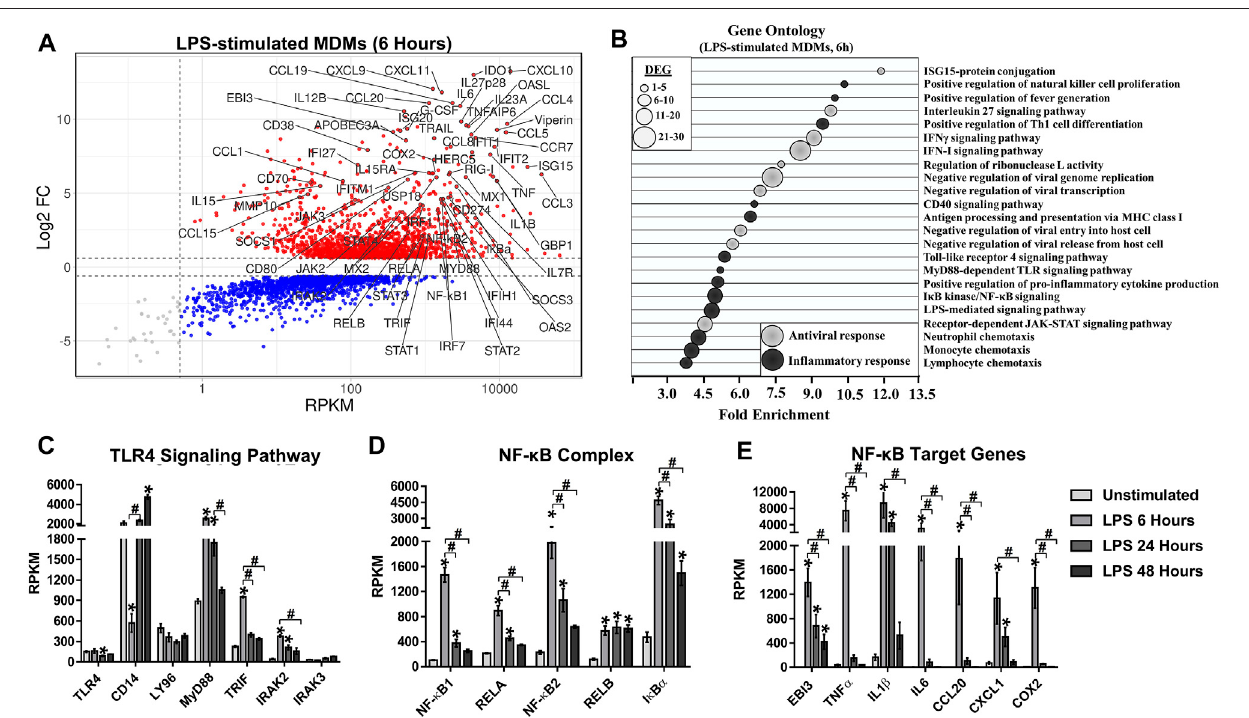
FIGURE 3 | TLR4 activation in human MDMs triggers NF- κ B-complex activation which drives the NF- κ B-target genes expression. We reanalyzed a publicly availableRNA-seqdataset[(GSE84188(GEO)(Olejniketal.,2017)],obtainedfromhumanMDMsstimulatedwith100 ng/mlofLPS,for6,24or48 h.MAplotofDEG (A) and GO enrichment analysis (B) from DEG regulated in LPS-stimulated MDMs at 6 h and. DEG in LPS-stimulated MDMs was selected from genes with an FDR < 0.05 and |Log2 Fold Change (LPS-stimulated MDMs/unstimulated MDMs | > 0.6. To quantify mRNAs abundance, we use the Reads per kilobase per million mapped reads (RPKM). n = 3. mRNAs abundance (RPKM) of TLR4 signaling pathway components (C) , NF- κ B-complex components (D) , and NF- κ B-target genes (E) in unstimulatedandLPS-stimulated MDMs.Dataarepresentedasthemean ±SEM.Kruskal – Wallis testwithDunn ’ spost-testwasperformed.Signi fi cantresultsbetween unstimulatedandLPS-stimulatedMDMsarede fi nedas p < 0.05(*), p < 0.01(**)and p < 0.002(***).Signi fi cantresultsbetweentreatment-timescomparisonsarede fi ned as p < 0.05 (#), p < 0.01 (##) and p < 0.002